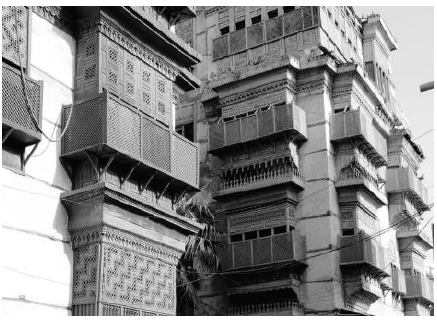
Figure 2. The vernacular house of the Hejaz type [48].